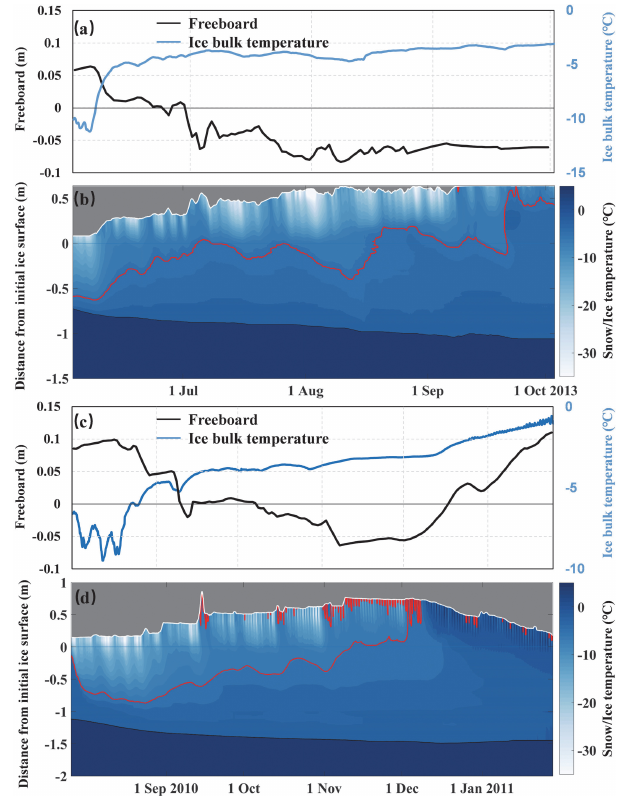
Figure 9. Estimated sea ice freeboard and ice bulk temperature, and temperature contours in the snow and sea ice measured by (a and b) ZS2013b and (c and d) ZS2010. The white, red, and black lines in panels (b) and (d) represent the snow surface, the − 5 ◦ C isotherm, and the ice bottom, respectively. The y axis zero value denotes the initial snow-ice